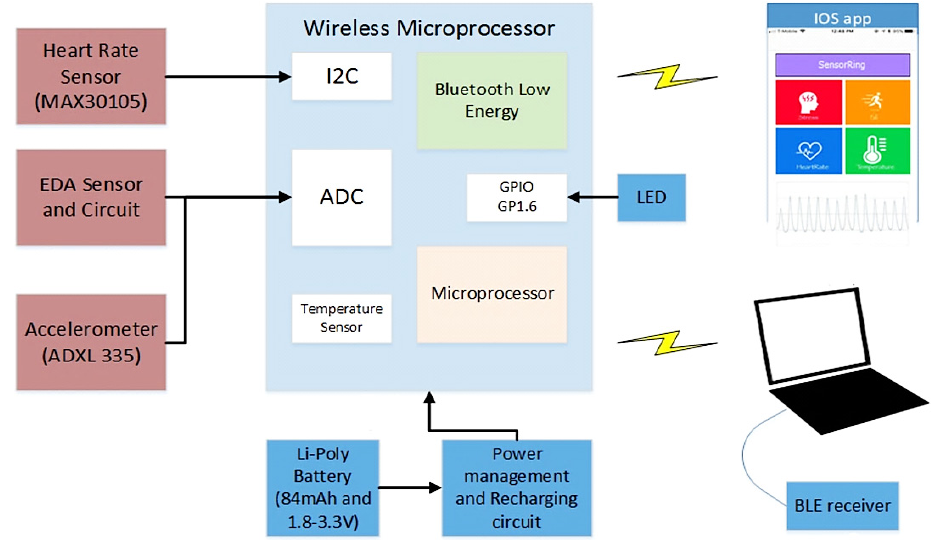
Figure 12. Sensor architecture in SensoRing proposed in [47] (Reprinted with permission from ref. [47]. Copyright 2021 IEEE).